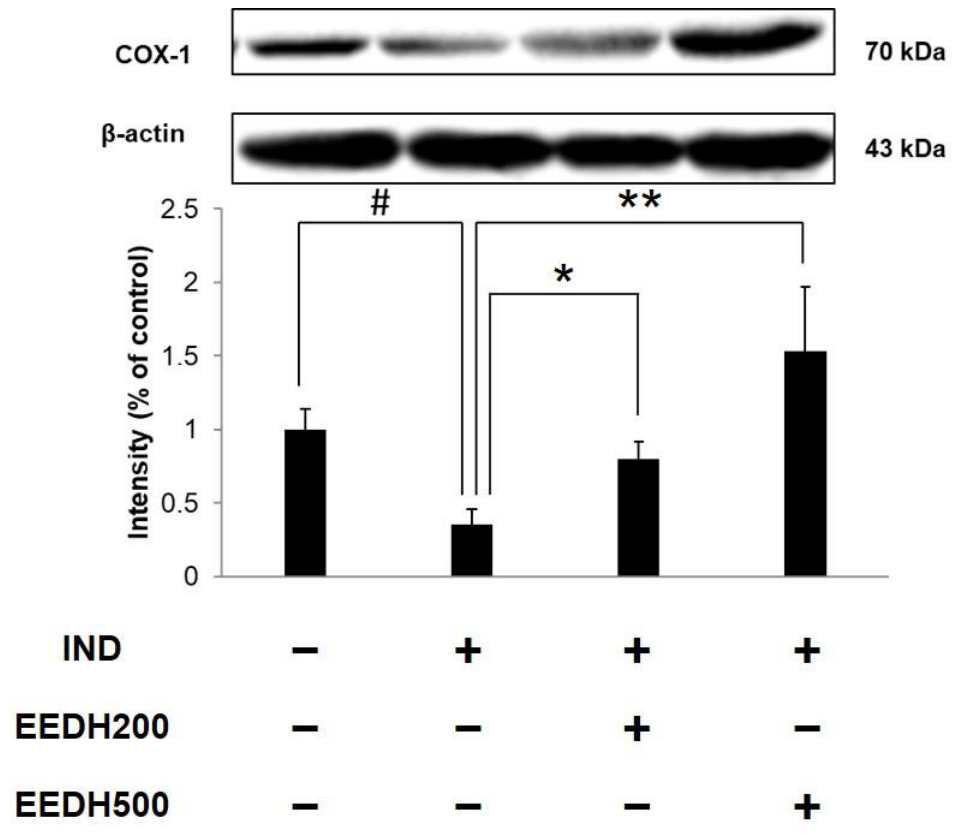
Figure 4. Effects of EEDH pretreatment on the protein levels of COX-1 of gastric mucosa in mice administered with IND. Western blot was applied to determine the expression of COX-1. Data are represented as means ± SD ( n = 3). # p < 0.05 compared with control group. * p < 0.05 and ** p < 0.01 compared with IND-treated group.